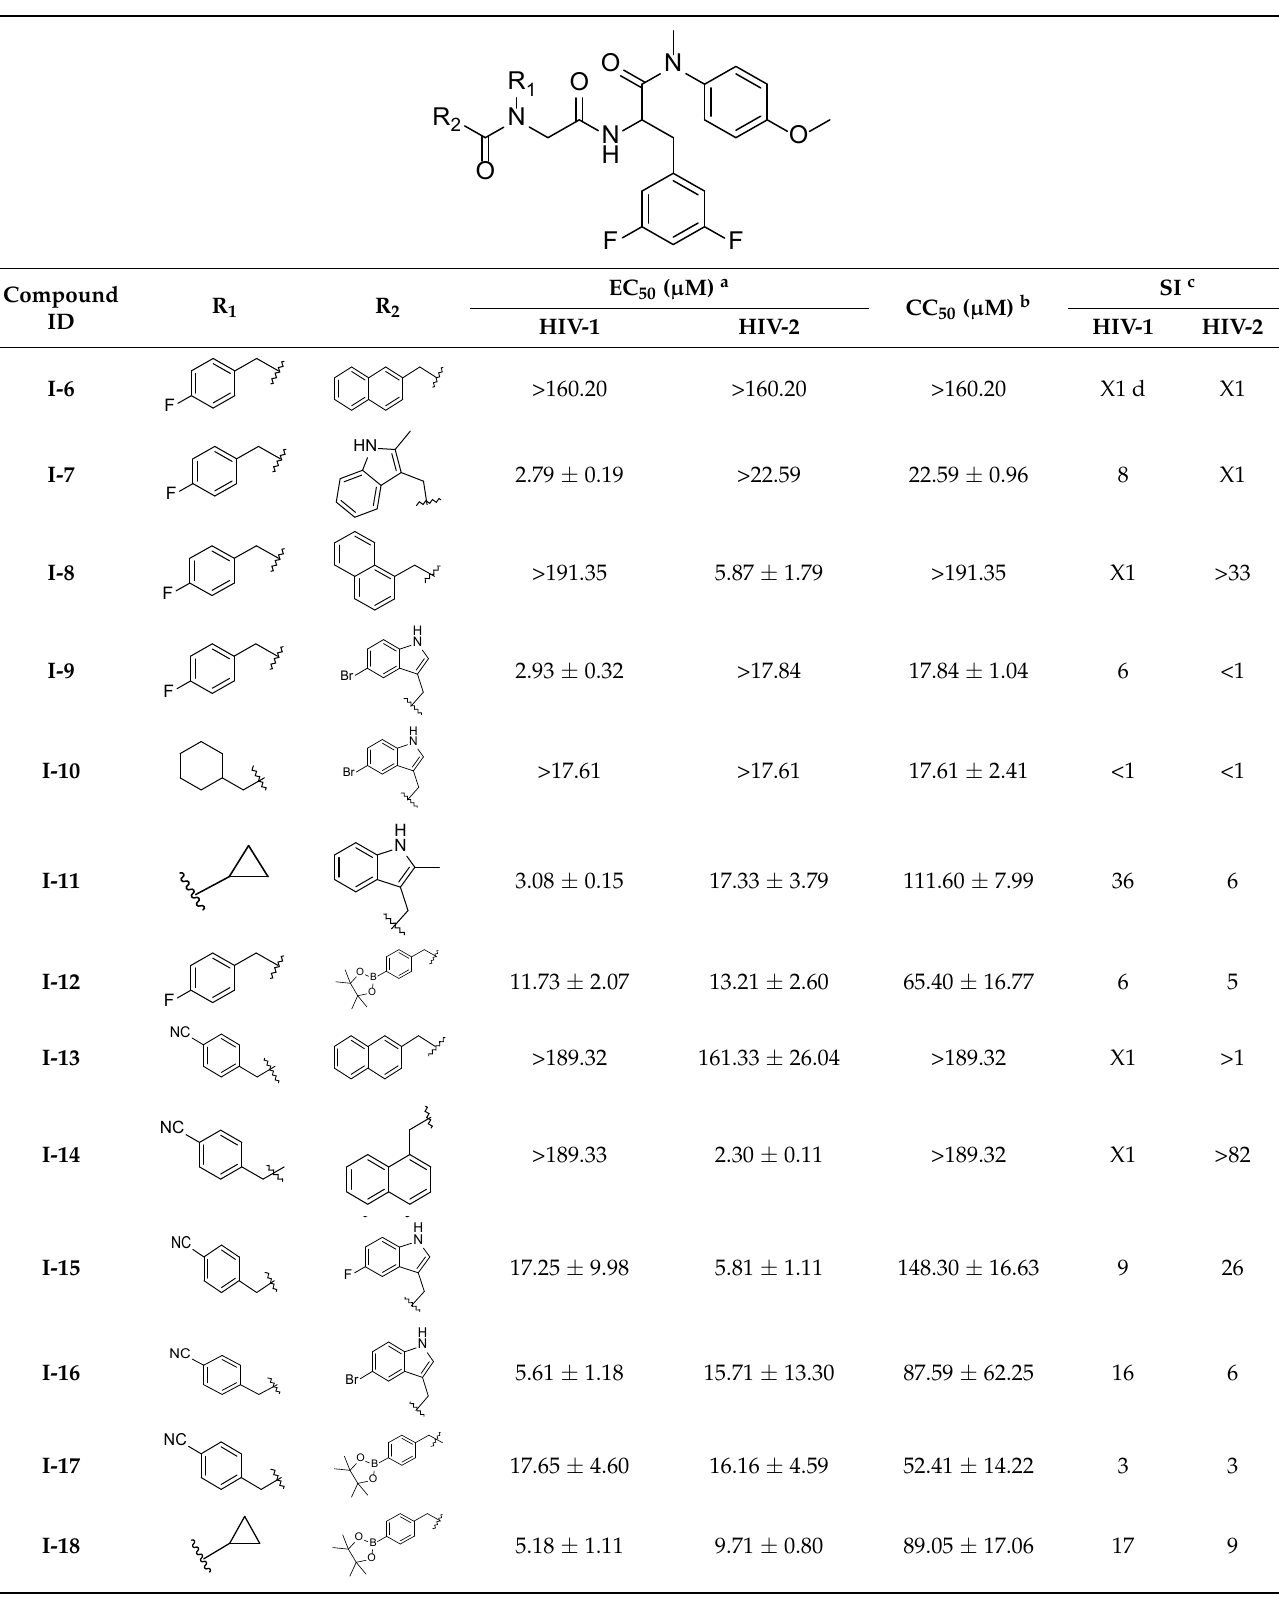
Table 1. Anti-HIV-1/HIV-2 activity of novel phenylalanine derivatives.